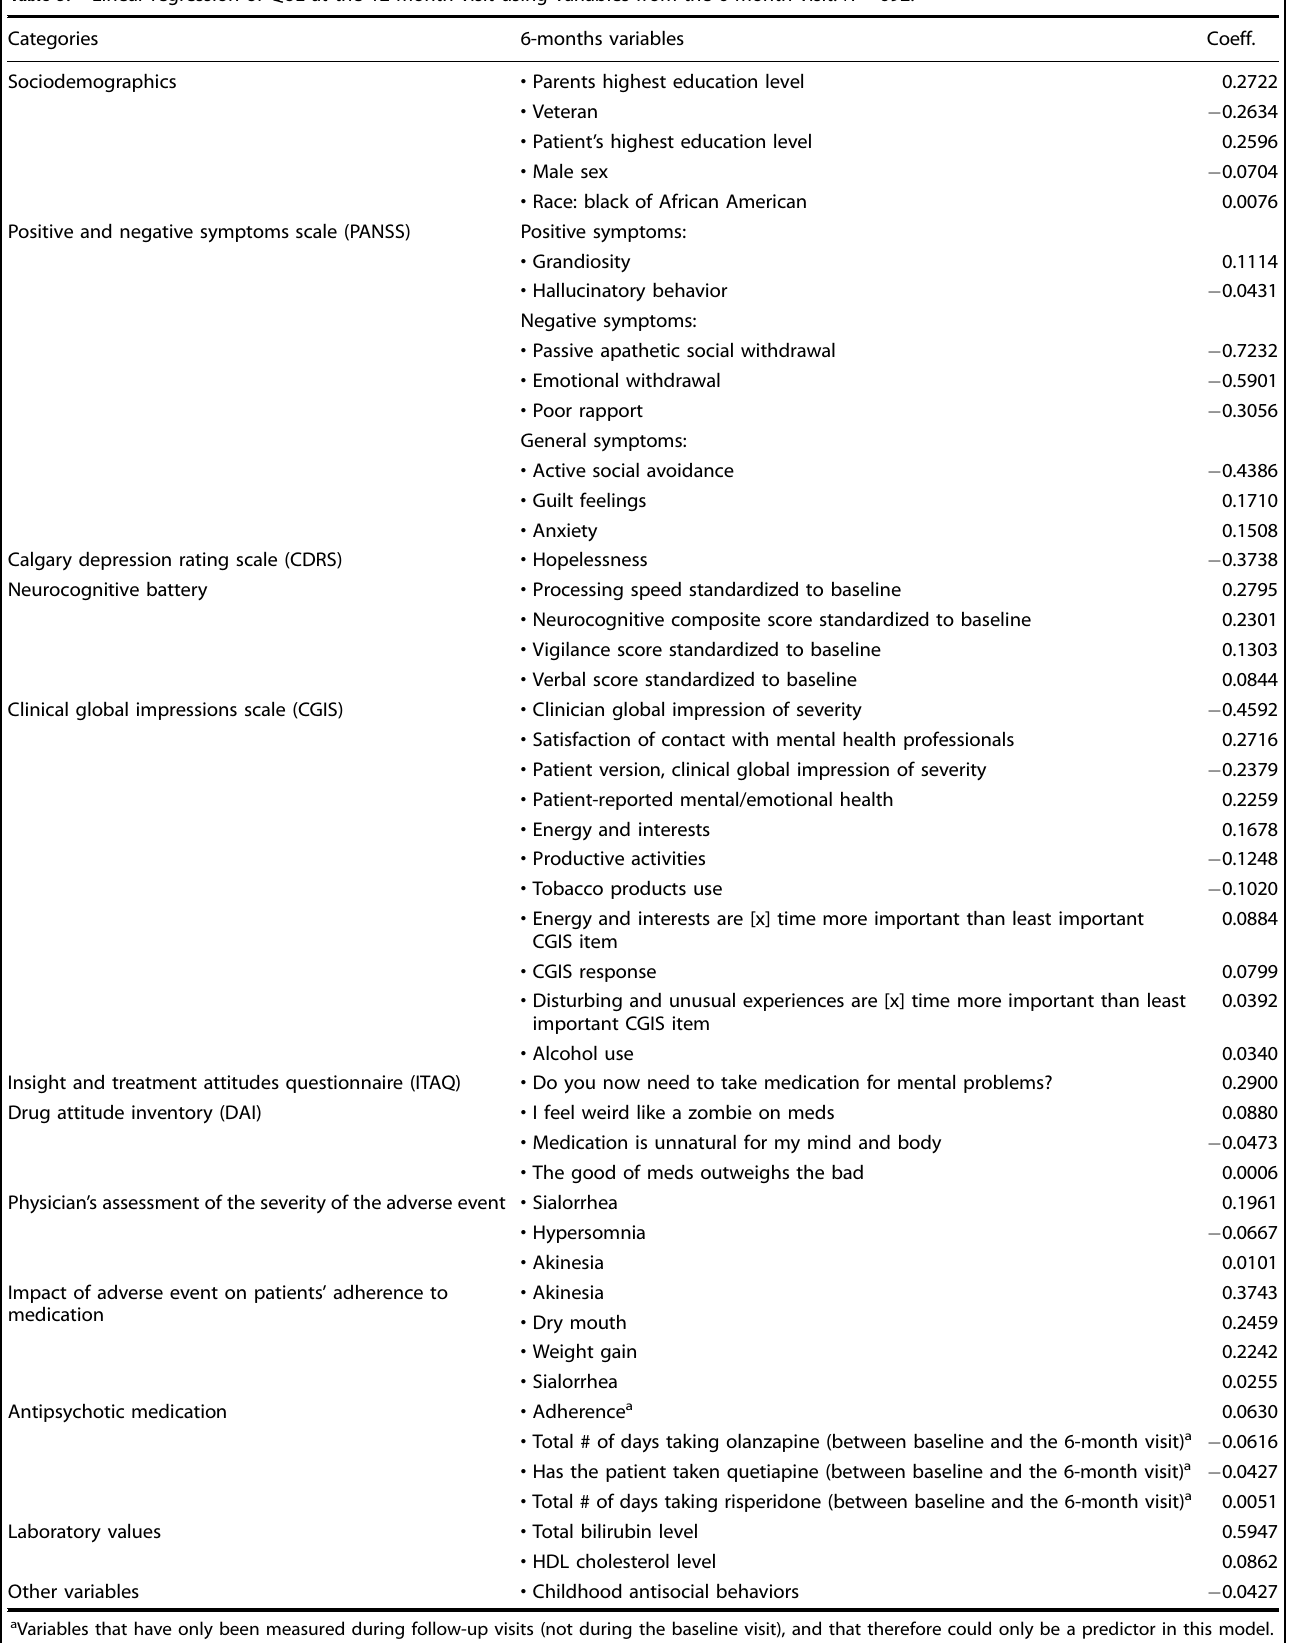
Table 3. Linear regression of QoL at the 12-month visit using variables from the 6-month visit. N = 692.